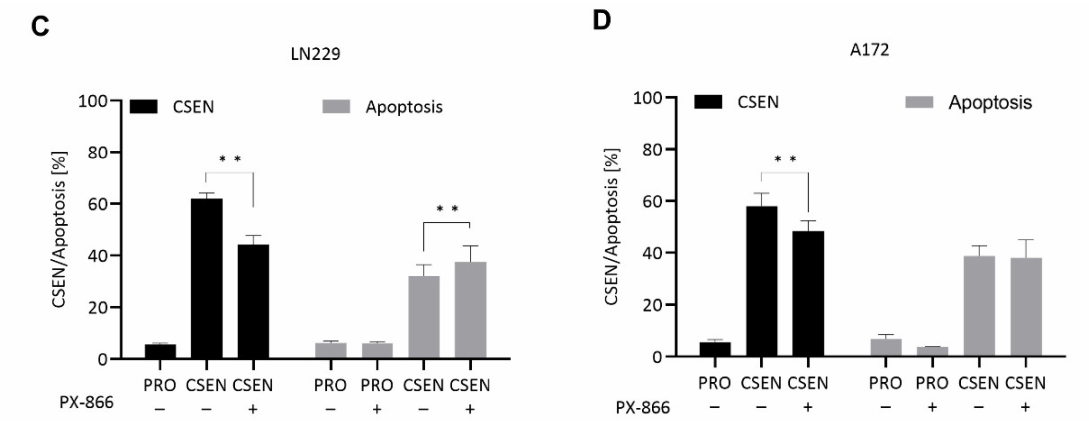
Figure 4. Identification of autophagy inhibitors as senolytic compounds. Proliferating (PRO) and senescent (CSEN) LN229 and A172 cells were treated with several substances to test their senolytic capacity. A significant decrease in senescence was observed by chloroquine (20 µ M) in LN229 cells ( A ) as well as PX866 in LN229 and A172 cells ( C,D ). Both substances induced apoptosis in senescent LN229 ( A,C ), but not A172 ( B,D ) cells. Data represent the mean of >3 independent experiments ± SEM. ** p < 0.01.